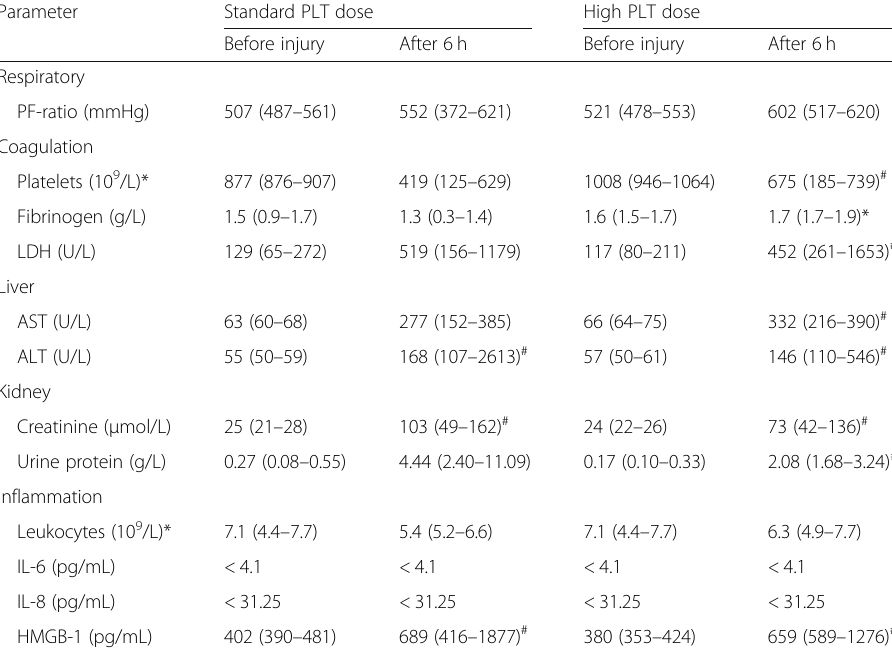
Table 3 Organ injury and inflammation Parameter Standard PLT